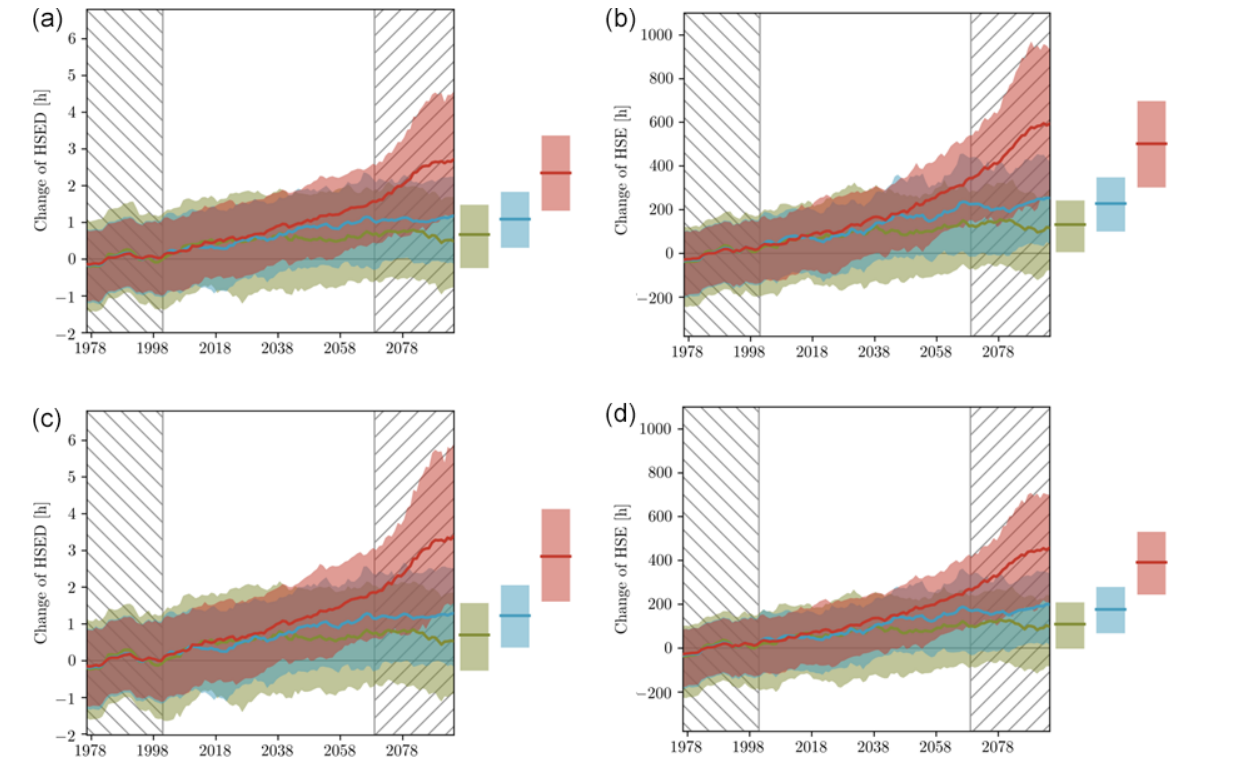
Figure 4. Projected change in heat stress events in the reference barn in central Europe (annual changes in panels a and b and summer changes in panels c and d ). Modifications in average duration (average consecutive hours) and number (number of consecutive hours) of moderate stress events under RCP 2.6 (green), RCP 4.5 (blue) and RCP 8.5 (red) are plotted based on the evolution of the temperature humidity index (THI) with a threshold of